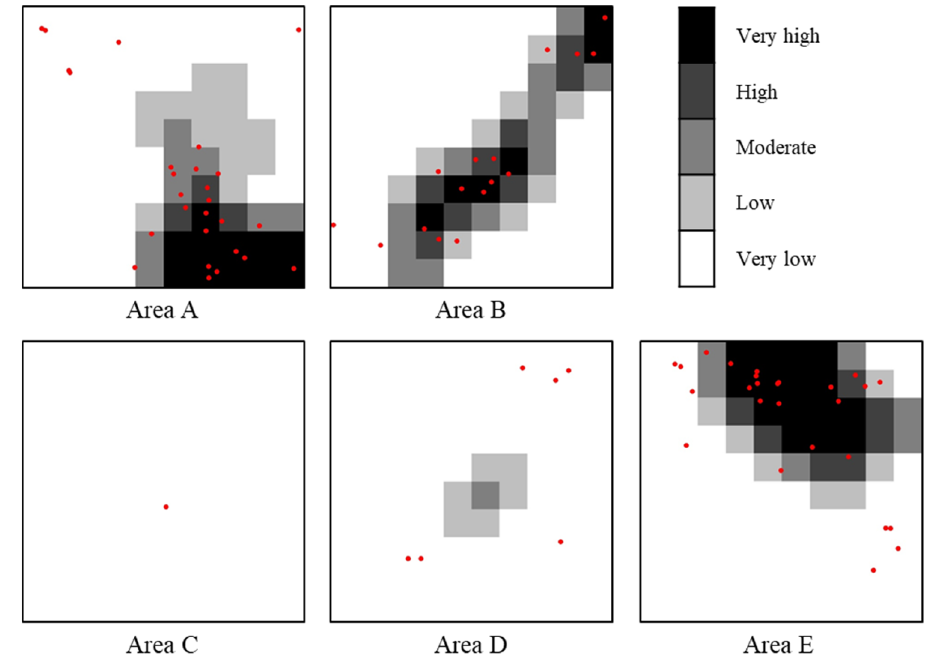
Figure 7. Ground sink susceptibility